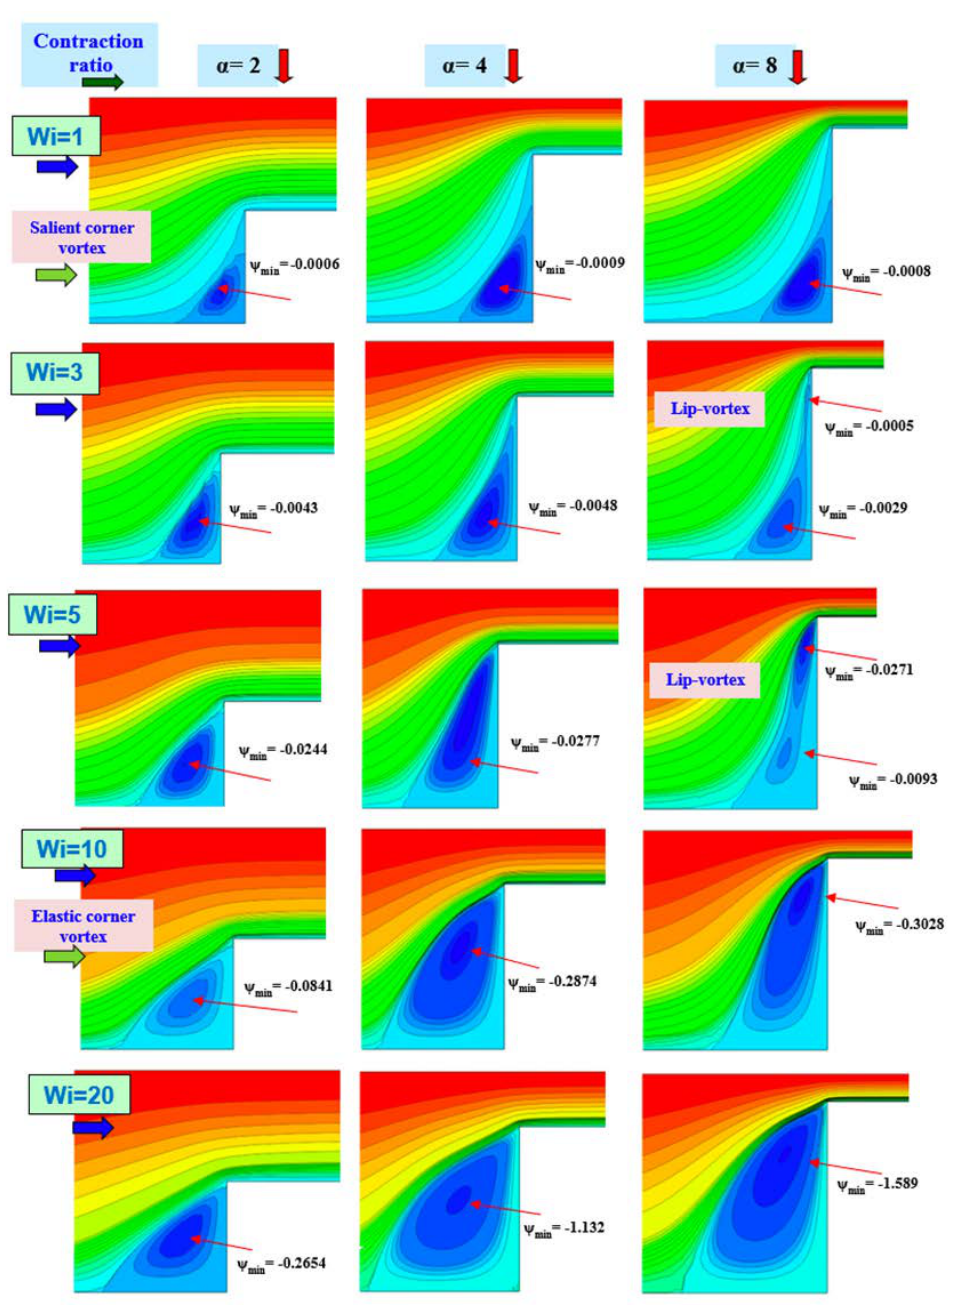
λ = 0.1. Figure 11. Streamlines; α aspect = {2, 4, 8}; Wi = [1, 20]; swIM [ L = 5, β ≤ 0.9]; λ D = D